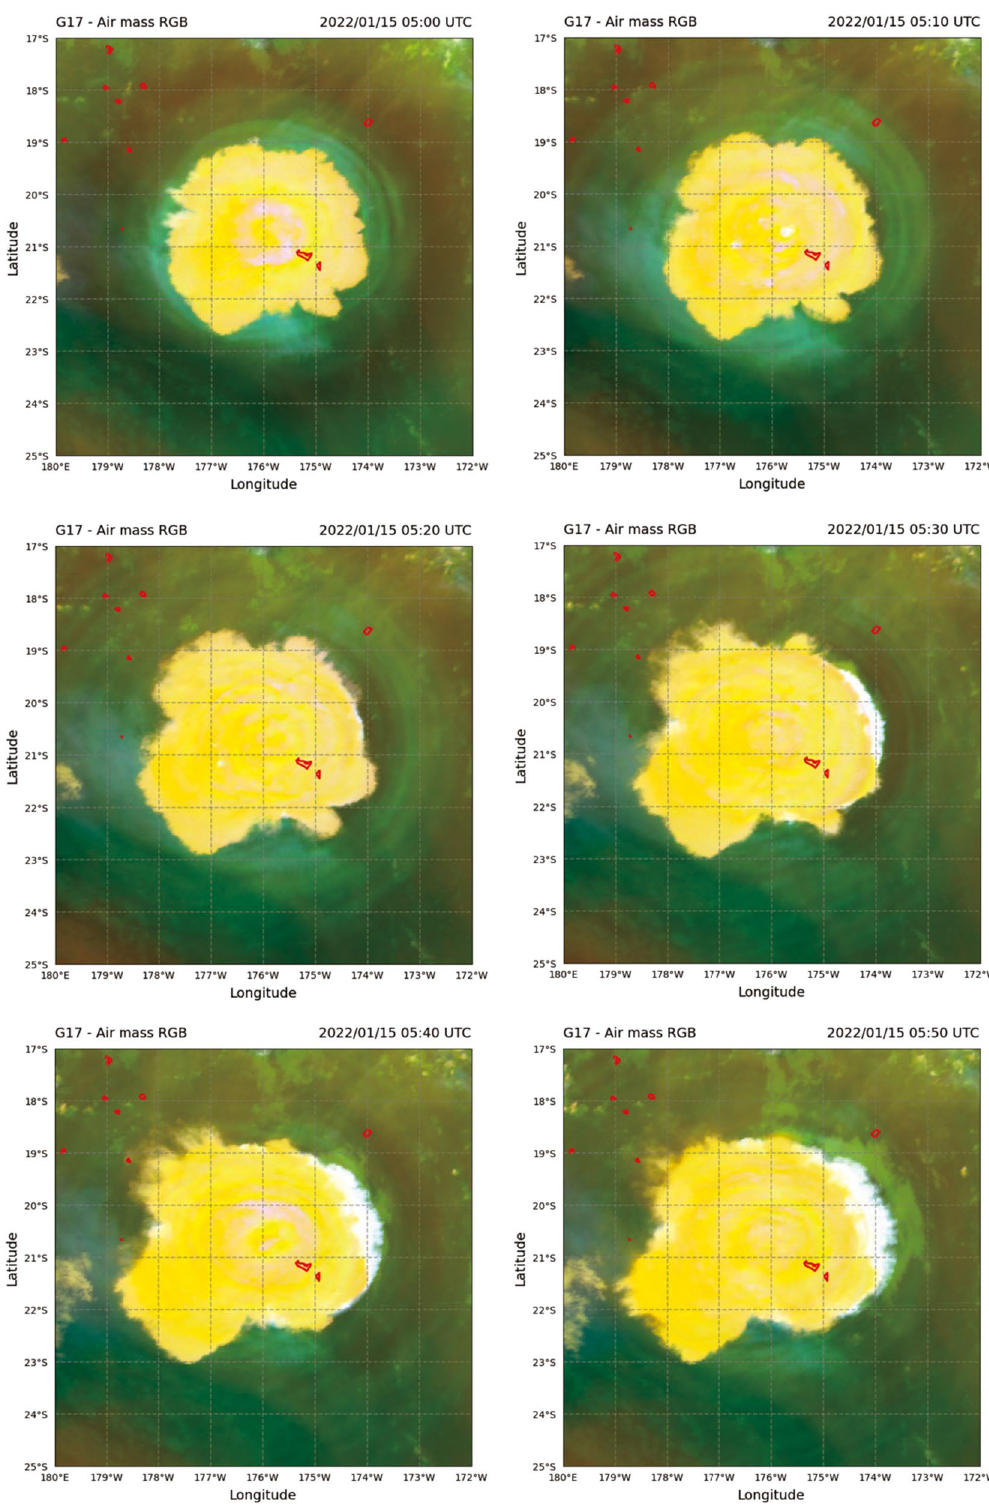
Fig. 14 Air mass RGB using GOES-17 from 05:00 to 05:50 on 15 January